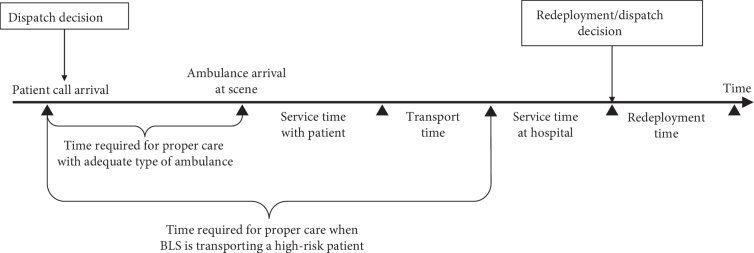
Flowchart of the ambulance operation process and decision-making points.